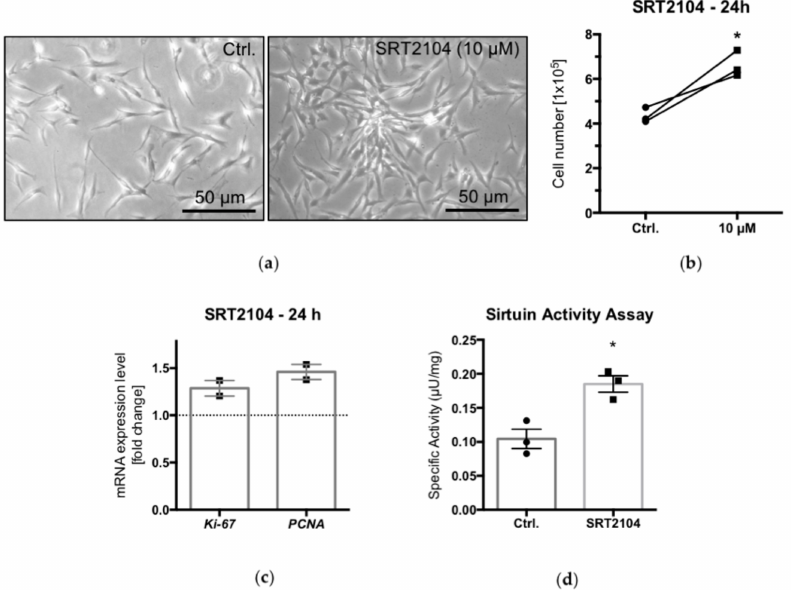
Figure 2. Live cell images of cultured KGN, under control conditions (Ctrl) and upon treatment with the SIRT1 activator SRT2104 (10 µ M) for 24 h: higher cell density in the SRT2104 group ( a ). Bars indicate 50 µ m. The measurement of cell numbers after SIRT1 activator treatment showed significantly increased cell numbers ( b ) ( n = 3; * p < 0.05, paired t -test). Results of qPCR measurements of known proliferation markers, Ki-67 and PCNA; results are normalized to control conditions ( c ). Bars indicate means and SEMs ( n = 2). Results of a SIRT activity assay revealed significantly increased deacetylation activity upon SIRT1 activator (10 µ M) treatment ( d ) ( n = 3; * p < 0.05, unpaired t